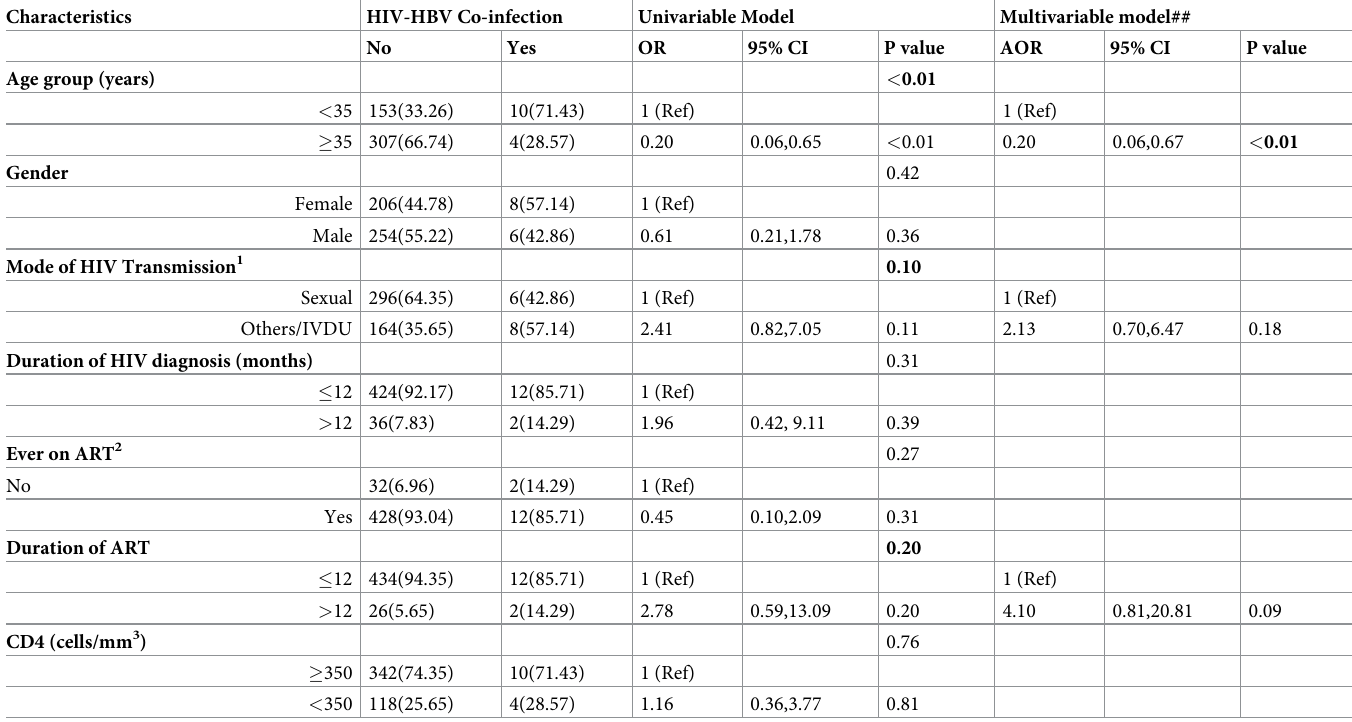
##Adjusted for age at HIV diagnosis, mode of HIV transmission and duration of ART. 1 Other mode of transmission is primarily IVDU as there were no cases of HIV-HBV co-infection in PLWH acquired through vertical mode of transmission (Table 1). 2 Currently on Anti retro-viral therapy